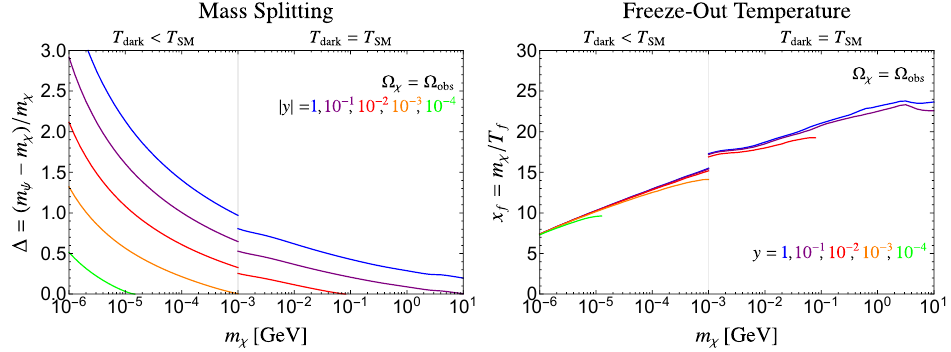
Figure 7 . Left : value of the mass splitting, (cid:1), that gives the observed relic density. We plot (cid:1) as a function of m (cid:31) and the coupling, y , controlling the size of the annihilation cross section. Light dark sectors require generic, O (1), mass splittings. Right : x f as a function of m (cid:31) and the coupling y . x f in coannihilating dark sectors is the same as for a WIMP, after (cid:12)xing the DM relic density to the observed value, and exhibits the same logarithmic dependence on the DM mass. Both (cid:12)gures were made for generic values of the phases: y = j y j e i(cid:25)= 4 and (cid:14) = j (cid:14) j e i(cid:25)= 4 . For m (cid:31) < MeV we show the results for a decoupled dark sector in equilibrium with its own dark radiation (see section